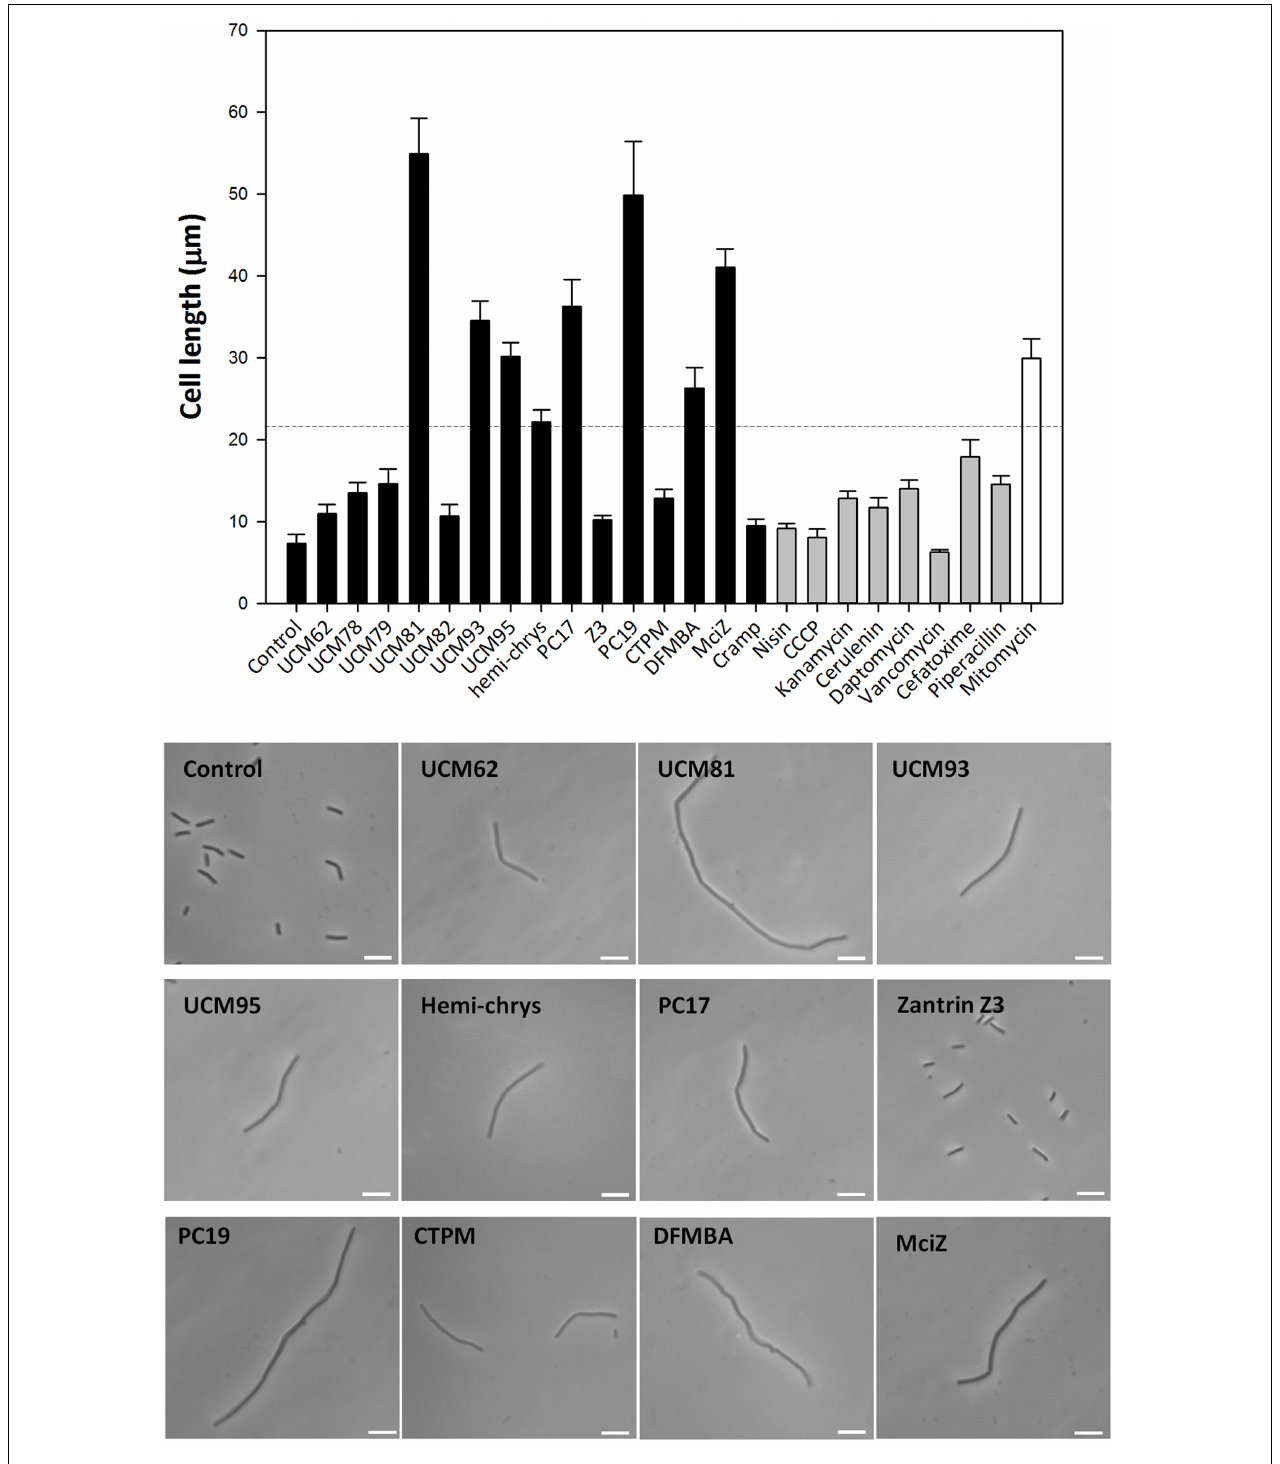
FIGURE 2 | Effect of FtsZ inhibitors and antibiotics with different mode of action in cell division. Cells of B. subtilis 168 were incubated for 3 h with the compounds, each one at its effective concentration, and cell length was measured (see Materials and Methods). Significant increases compared to the treatments with control antibiotics -with the exception of mitomycin- were found with compounds UCM81, UCM93, UCM95, hemi-chrysophaentin, PC170942 (PC17), MciZ, PC190723 (PC19), and DFMBA ( p < 0.05; dotted line). The histogram shows average and standard error from three independent experiments with more than 30 measurements each. Representative examples of undivided individual cells observed upon treatment with the compounds are shown in phase contrast. Scale bar: 10 µ m.